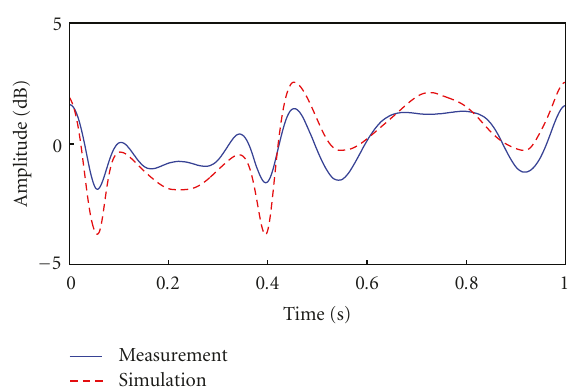
Figure 7: Waveform comparison of the normalized channel fading amplitude (dB) over one period with one measurementof S 12 ( d 10 = 19cm, d 12 = 19 cm).